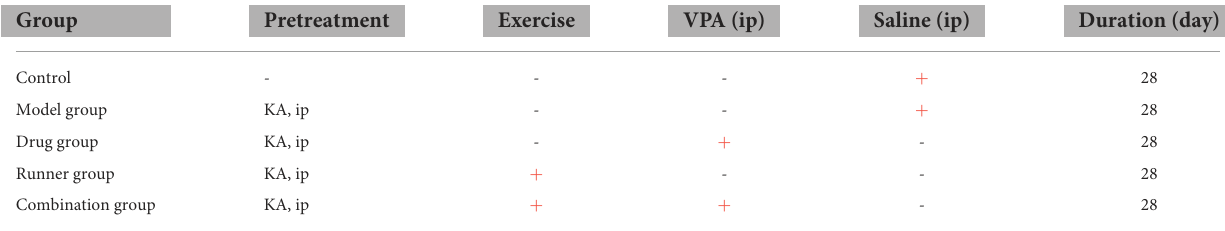
TABLE 1 Exercise and treatment program.